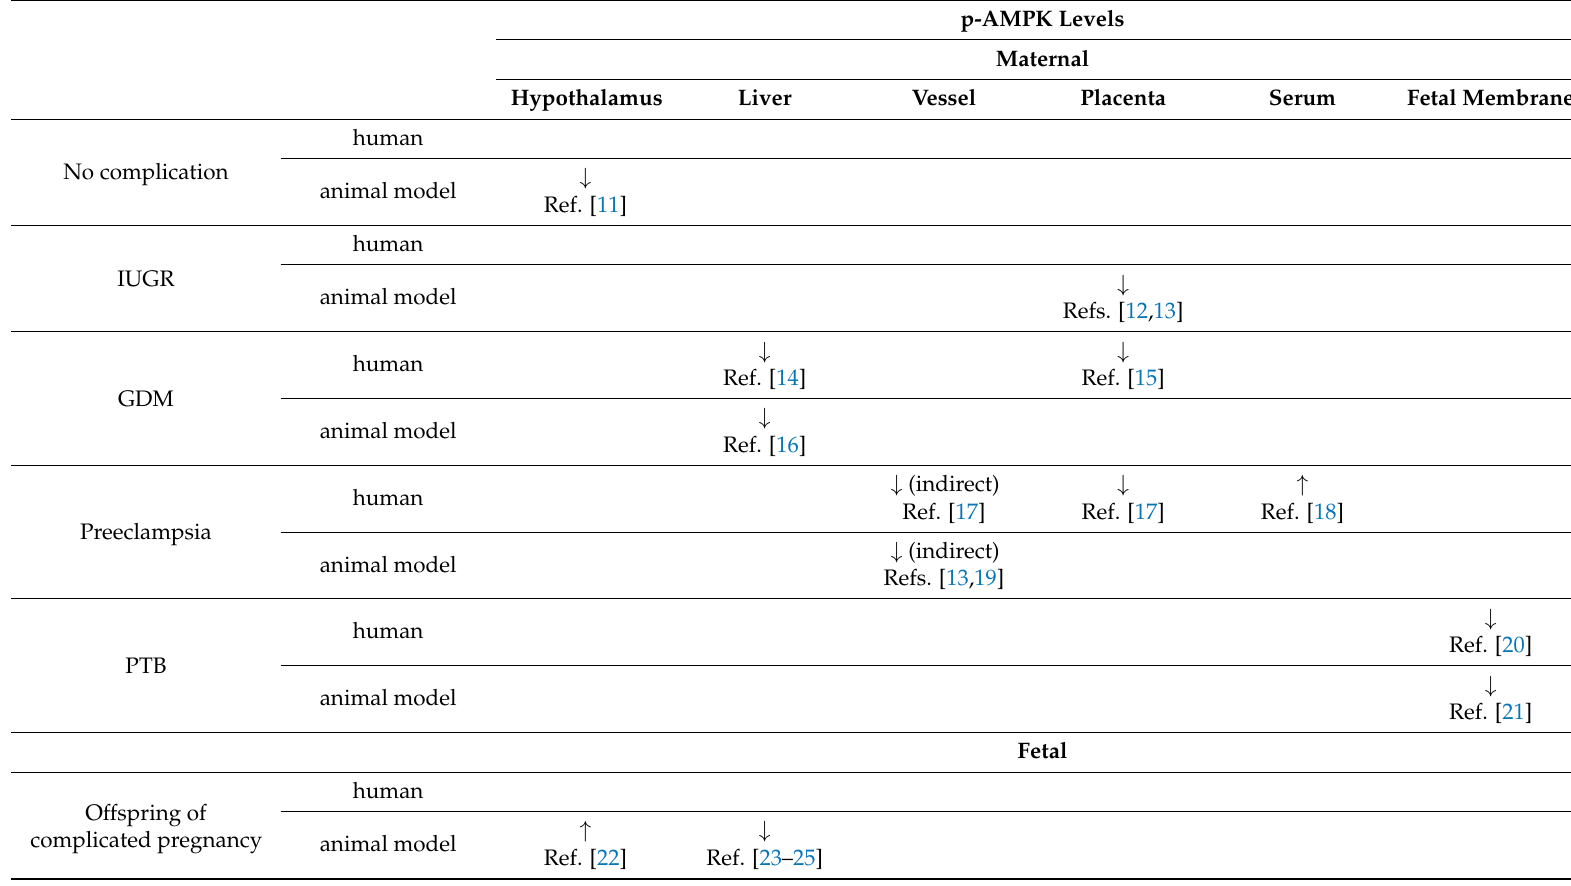
Table 1. Phosphorylated AMP-activated protein kinase (p-AMPK) levels in different organs during pregnancies with